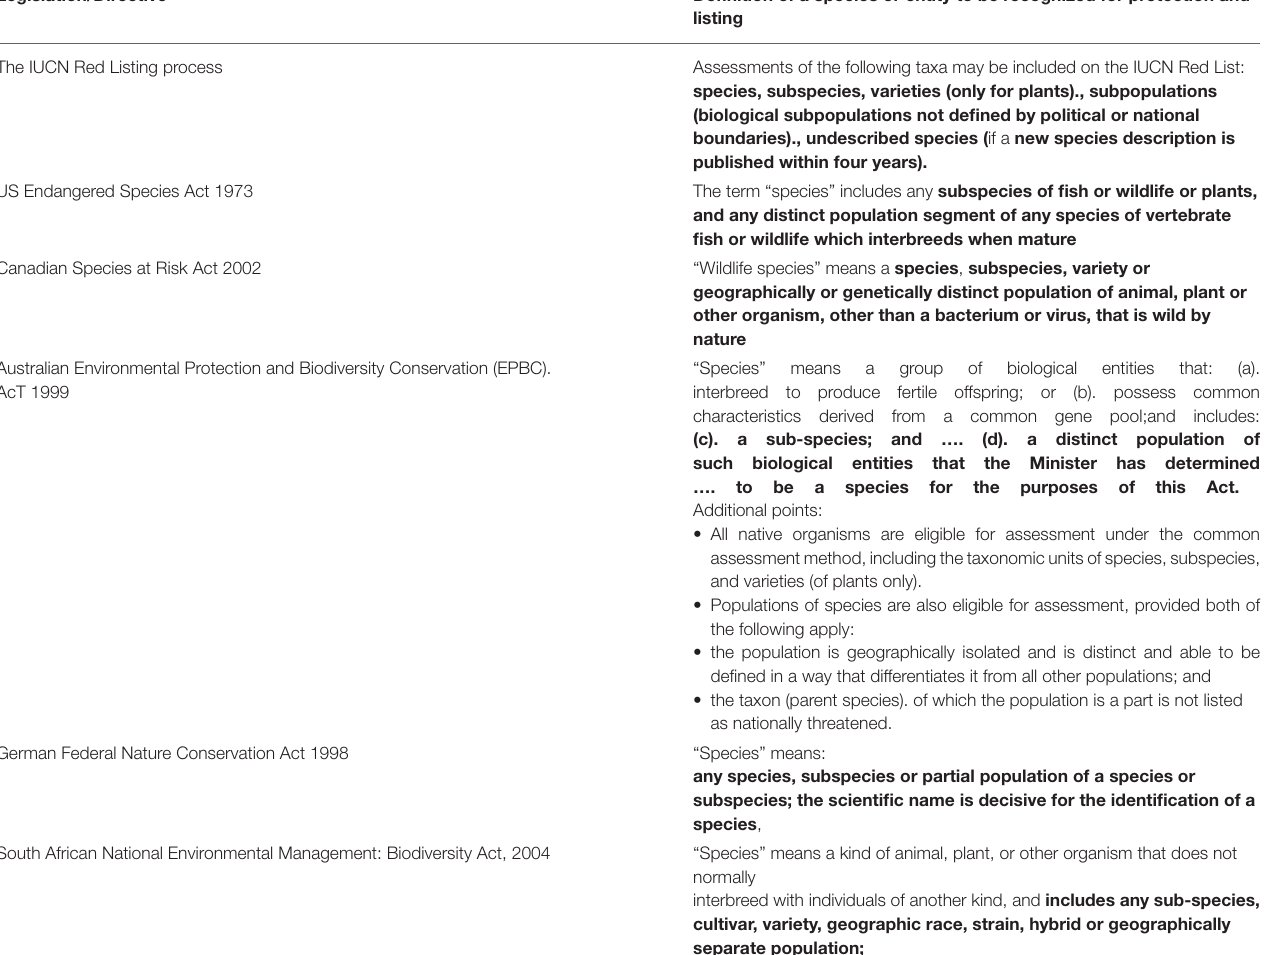
TABLE 1 | World legislation and directives that define “species” for listing and